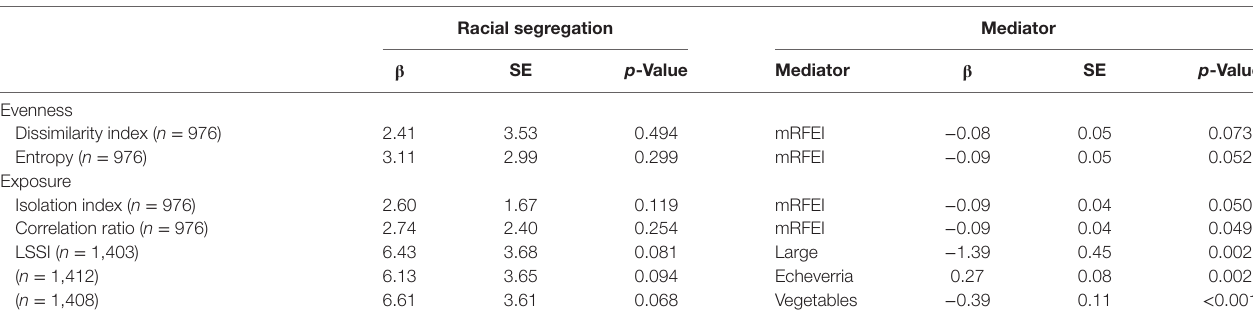
Mediated models—segregation and BMi with mediators: food environment (mrFei),